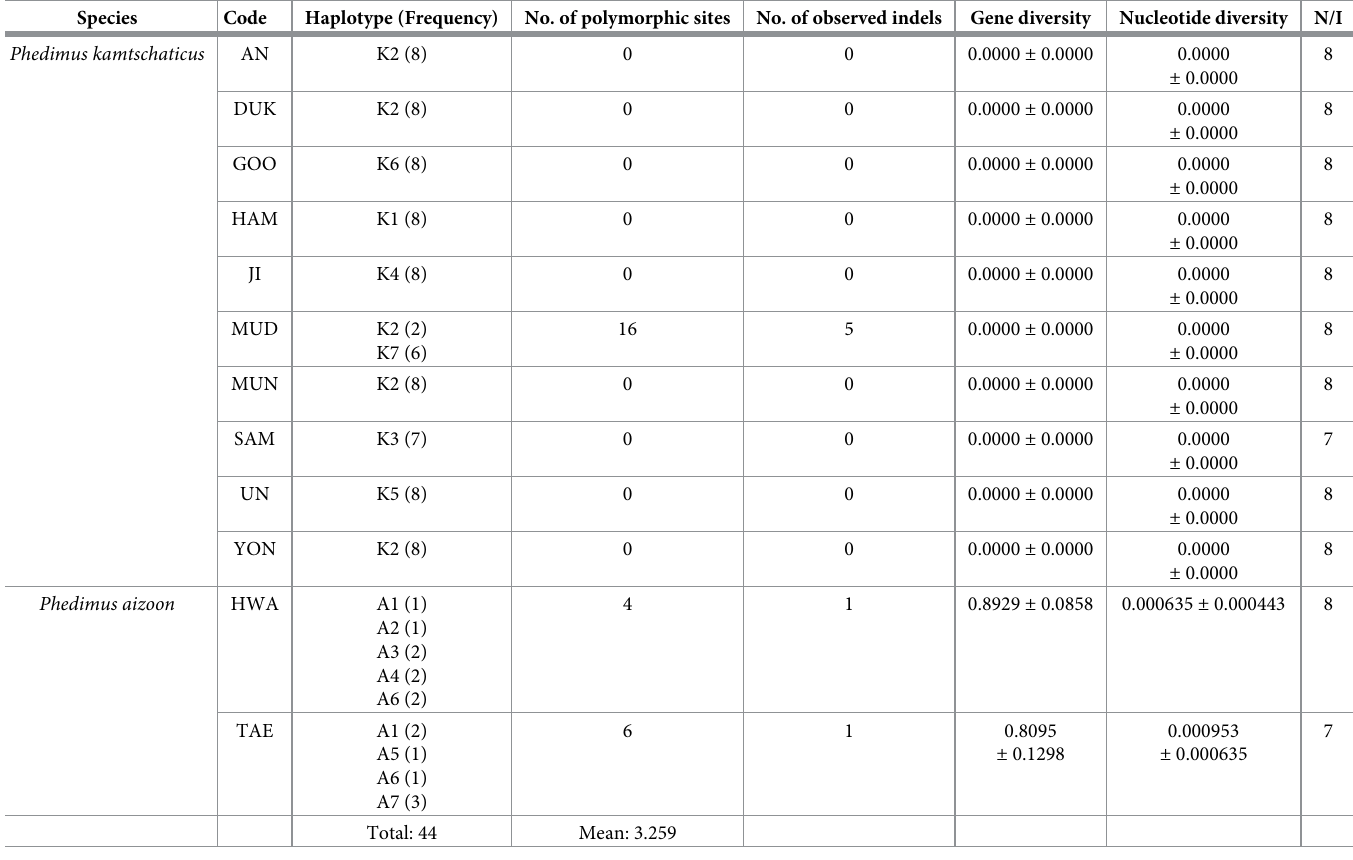
to 0.002967 ± 0.001672 (CHU), respectively. One population (DON) on Dokdo Island con- tained three haplotypes (T4, T29, and T30), and showed gene diversity of 0.3778 ± 0.1813 and nucleotide diversity of 0.001561 ± 0.000927 (Table 2 and Fig 2). For the two populations of P . aizoon , much higher gene and nucleotide diversity were observed; 0.8929 ± 0.0858 and 0.000635 ± 0.000443 for HWA and 0.8095 ± 0.1298 and 0.000953 ± 0.000635 for TAE, respec- tively. Overall, P . takesimensis and P . aizoon showed similar levels of genetic diversity. In the case of nucleotide diversity, P . takesimensis and P . kamtschaticus are higher than P . aizoon (Table